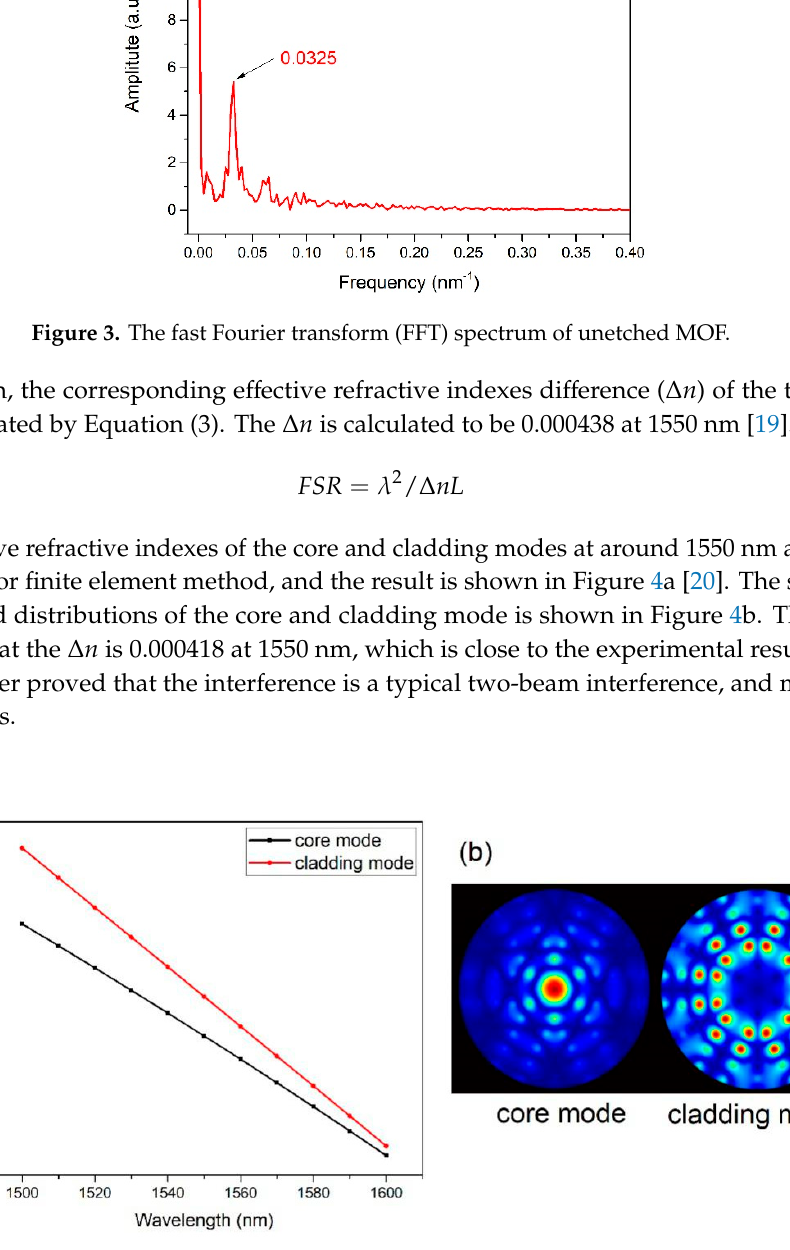
4 of 10 Figure 2. ( a ) Schematic of the experiment; ( b ) The transmission spectrum of unetched MOF and